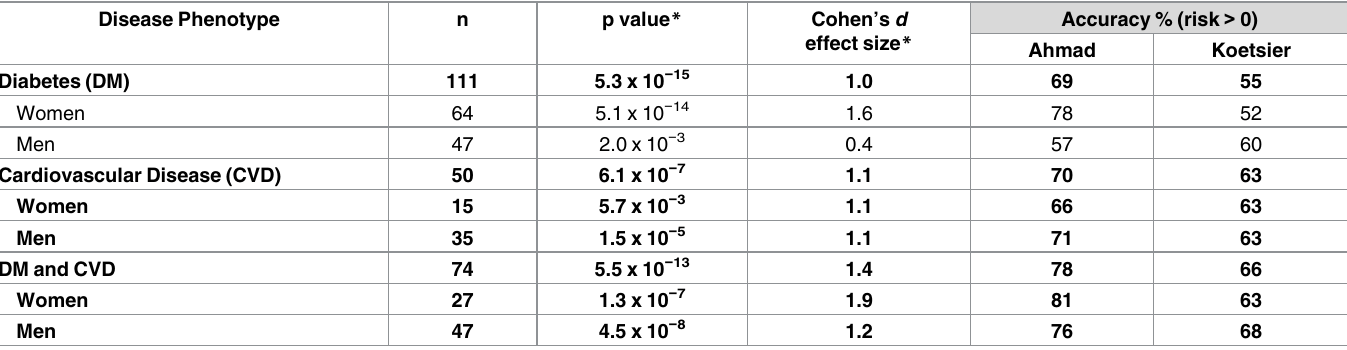
Table 2. Associations of SAF with different disease phenotypes in an Arab cohort. Disease Phenotype